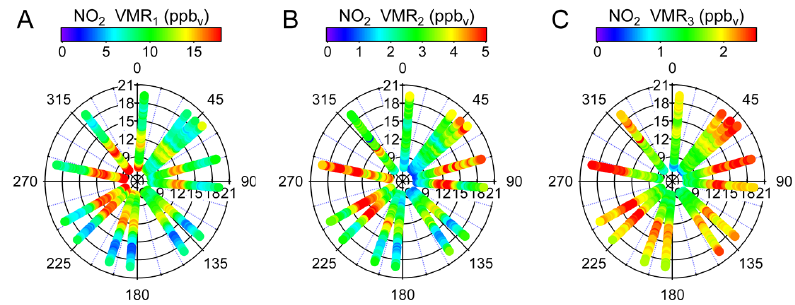
Figure 9. Azimuth dependence of the NO 2 VMR diurnal cycle at the three distances accessible to the onion-peeling approach. The NO 2 in the vicinity of the site (VMR 1 ) is determined at 360nm; for calculations of the NO 2 VMR 2 and VMR 3 see Eq. (8) and text for details.